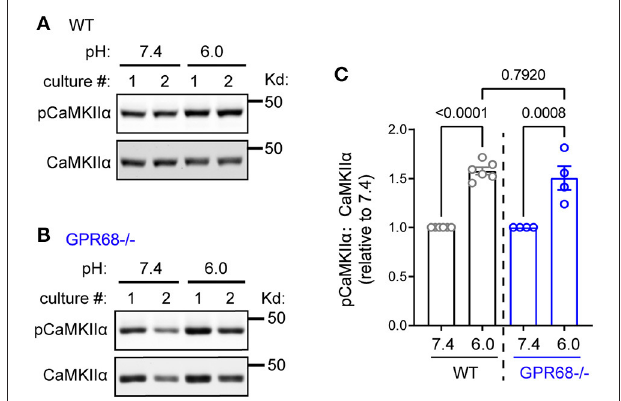
FIGURE 4 | pH 6.0-induced CaMKII α phosphorylation does not depend on GPR68. Representative Western blot and quantification of extracellular pH 6.0-induced immunoreactivity of pCaMKII α in WT (A,C) and GPR68 − / − (B,C) hippocampal slices, on acid-induced phosphorylation of Thr286 on CaMKII α (A,C) in WT hippocampal slices. Organotypic hippocampal slices were treated with pH media as indicated, lysed, and analyzed by Western blot. Blots and images were representative from 4 to 6 different cultures/pups (see Methods or Figure 2 Legends for additional clarification). P -values were from 2-way ANOVA with Tukey’s